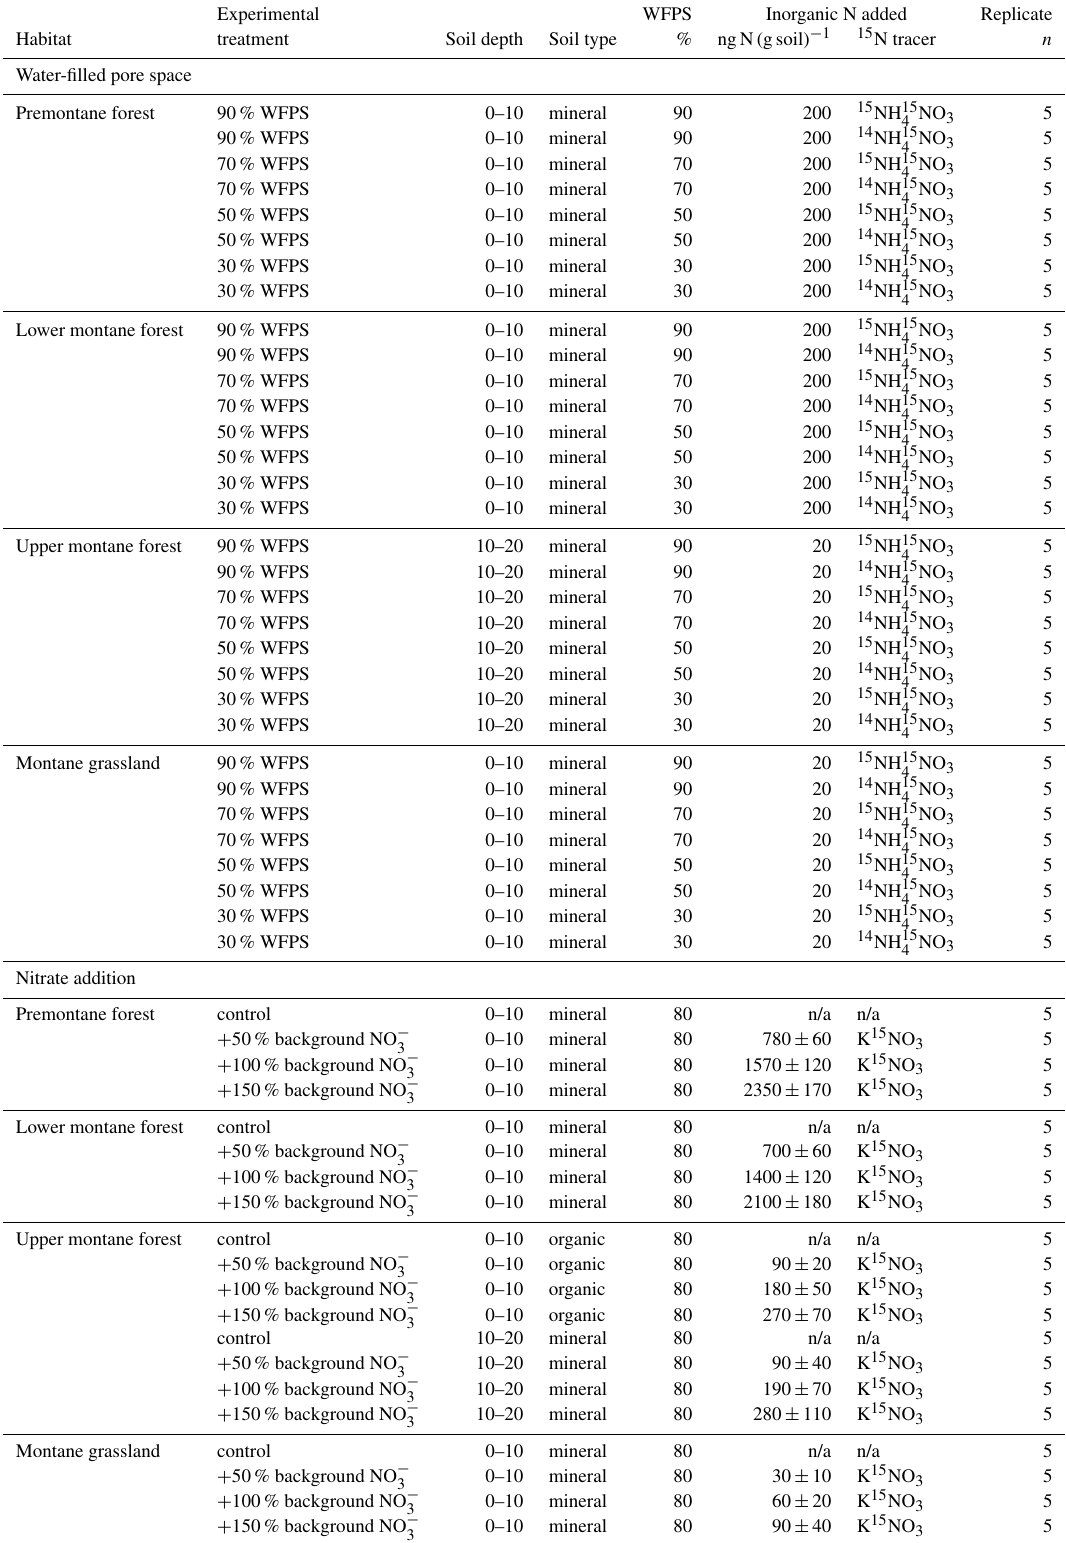
addition treatments for the laboratory manipulation experiments. 3